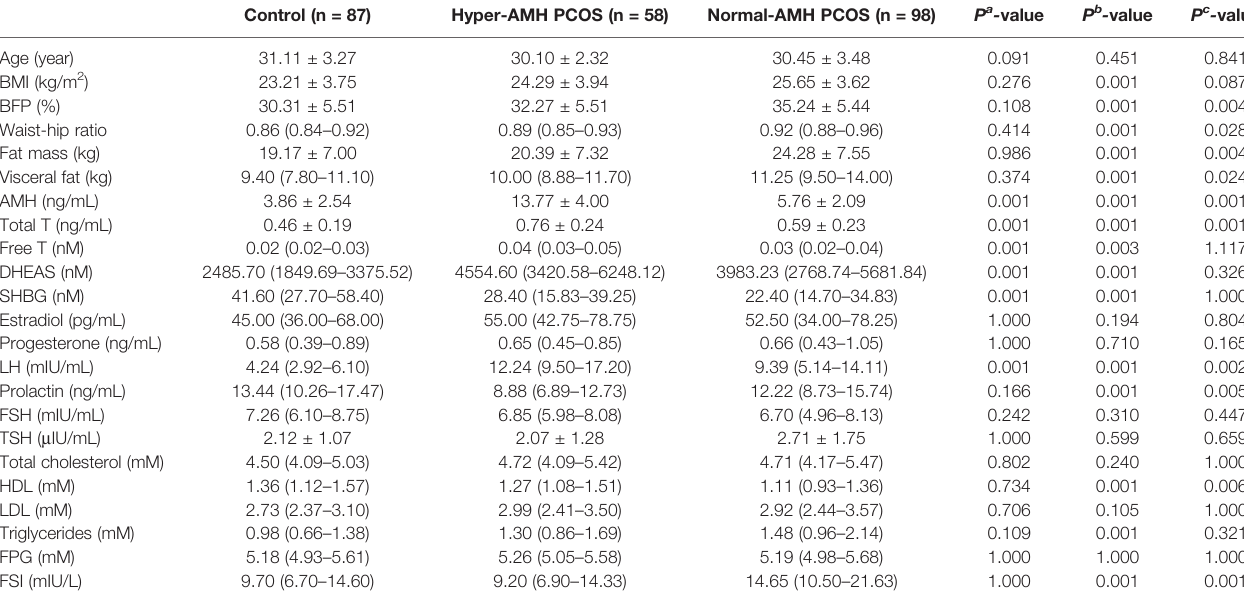
BMI, body mass index; BFP, body fat percentage; AMH, anti-Müllerian hormone; Total T, total testosterone; Free T, free testosterone; DHEAS, dehydroepiandrosterone sulfate; SHBG, sex hormone-binding globulin; LH, luteinizing hormone; FSH, follicle-stimulating hormone; TSH, thyroid-stimulating hormone; HDL, high-density lipoprotein cholesterol; LDL, low-density lipoprotein cholesterol; FPG, fastingplasma glucose;FSI, fastingserum insulin. Mean± standard deviationor median(interquartile range)areshown.P a , comparing thecontrol groupand hyper-AMH PCOS group. P b , comparing the control group and normal-AMH PCOS group. P c , comparing the hyper-AMH group and normal-AMH PCOS group. P-values were adjusted for multiple testing using the Bonferroni method and shown after post-hoc test.